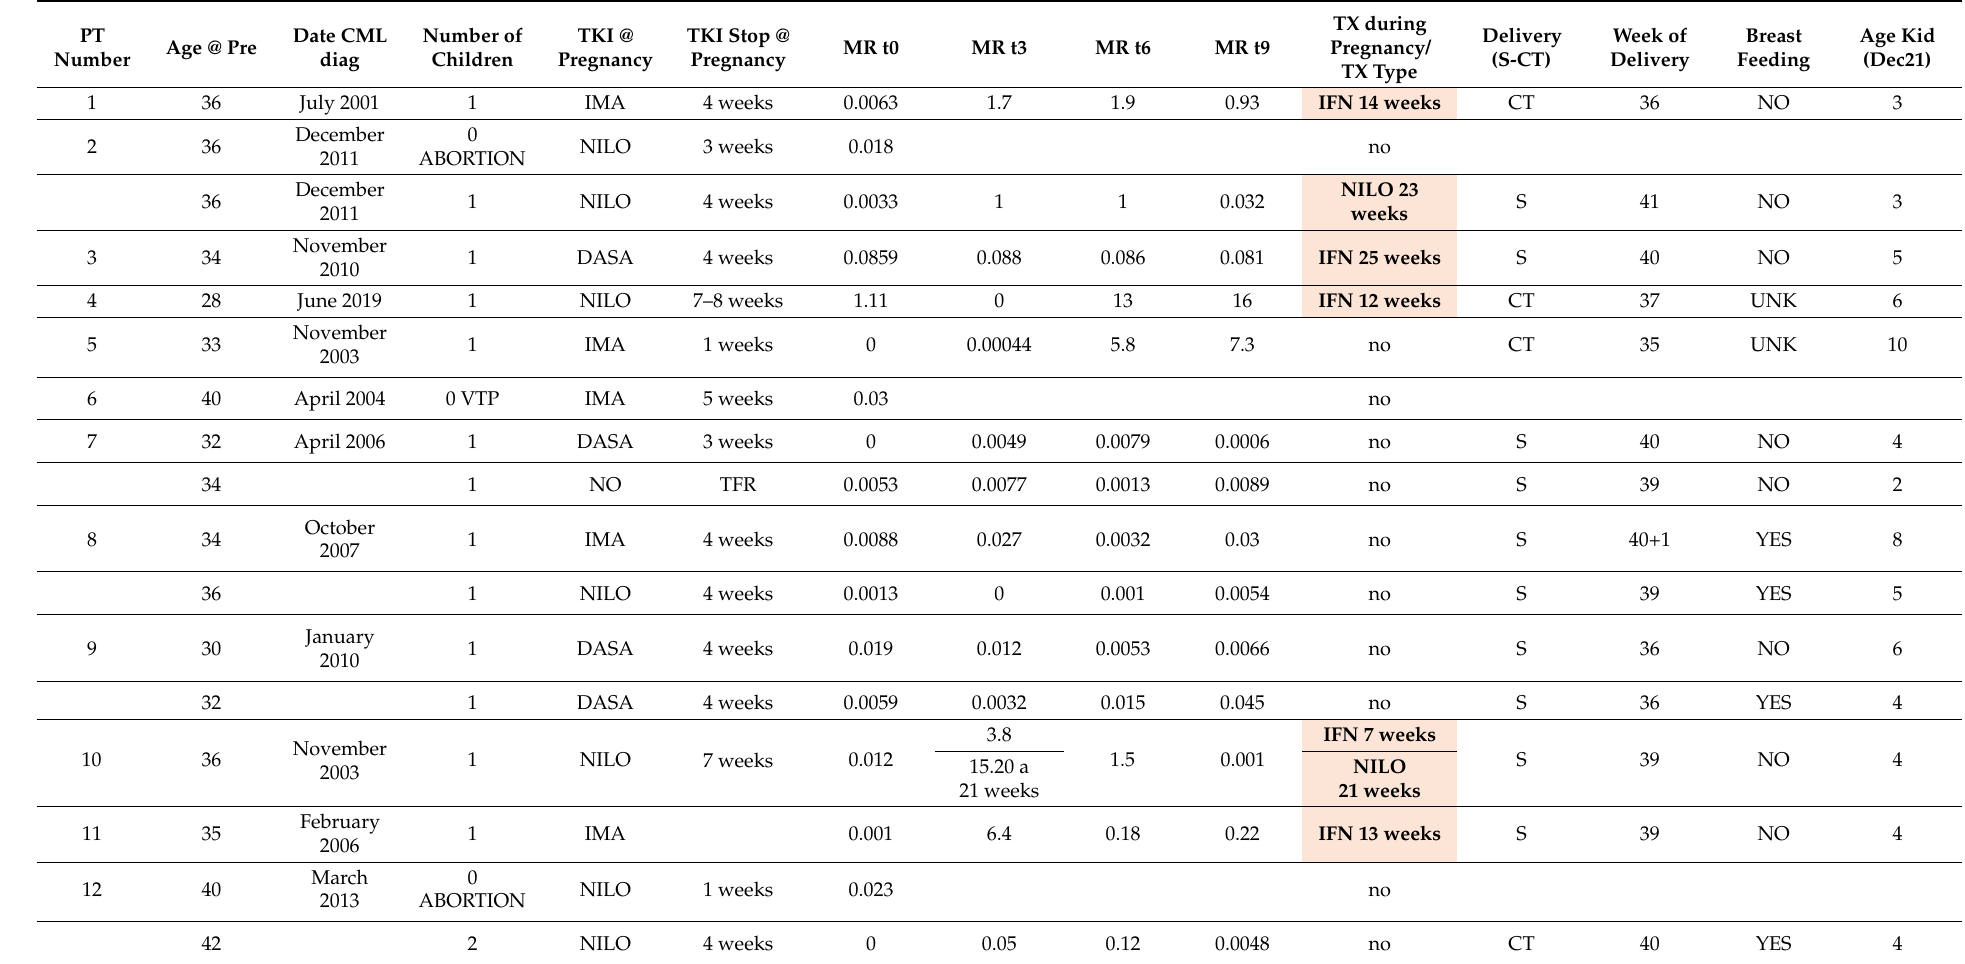
Table 2. Pregnancies in female CML